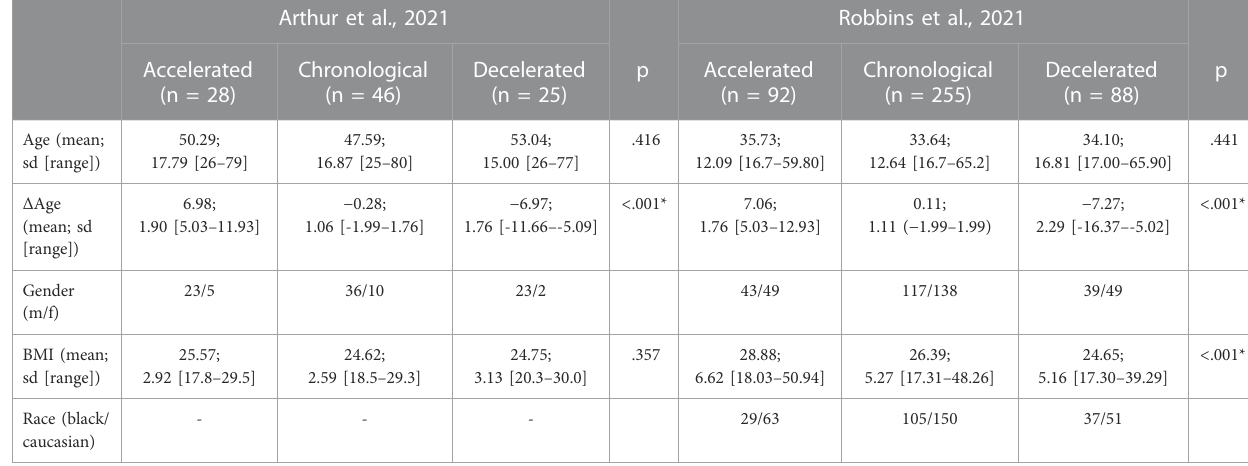
TABLE 2 Description of altered aging trajectory groups. Provided are the number of individuals per group, chronological age, the discrepancy of estimated proteomic and chronological age, and the demographics of the individuals. P -values indicate if there are differences for the given variables between the groups. Arthur et al.,